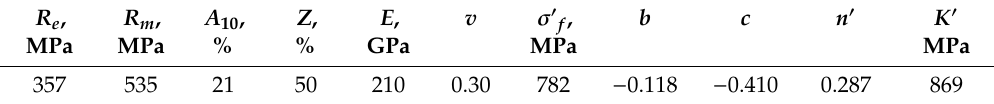
Table 2. Static and fatigue properties of the material.